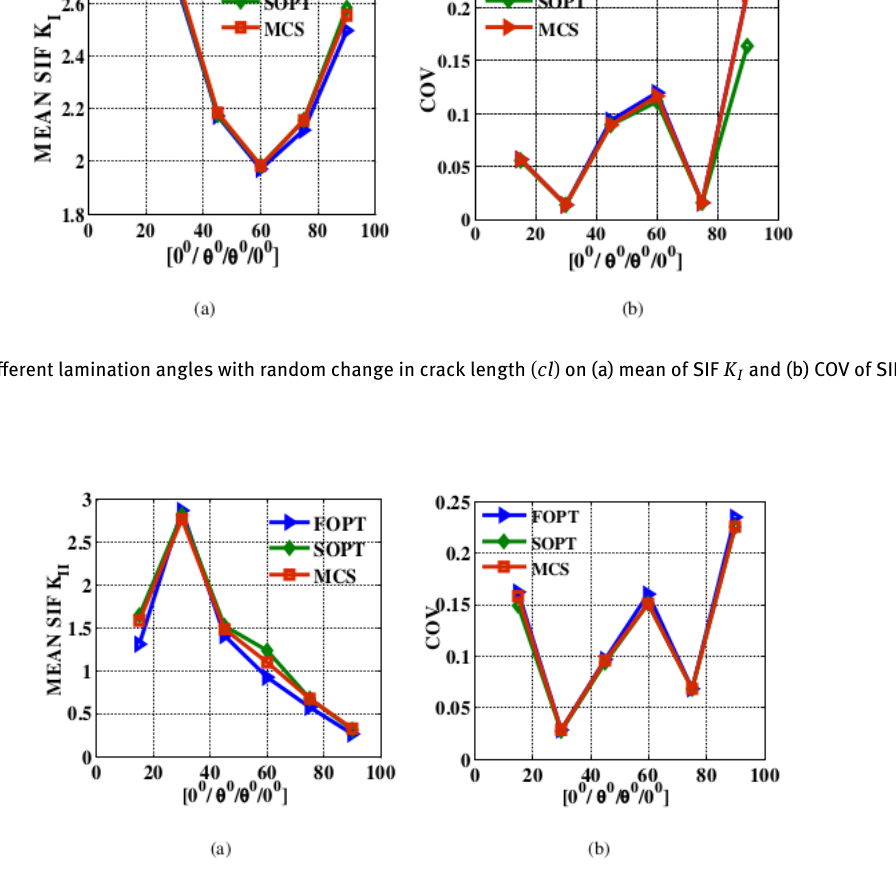
Figure 3: Effect of different lamination angles with random change in crack length ( cl ) on (a) mean of SIF K II and (b) COV of SIF K II